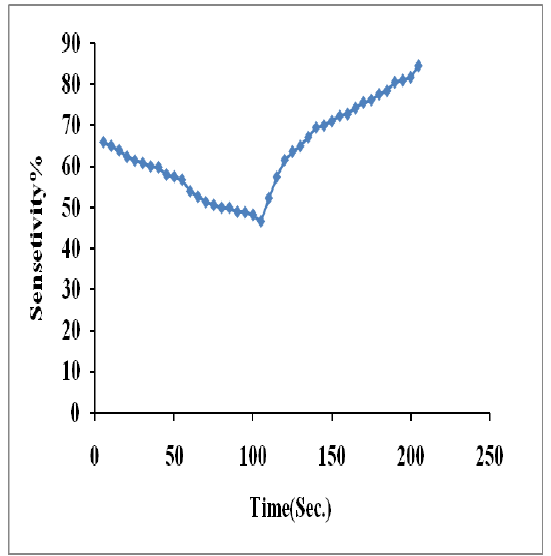
Fig. 7: Sensitivity of Sulfuric acid